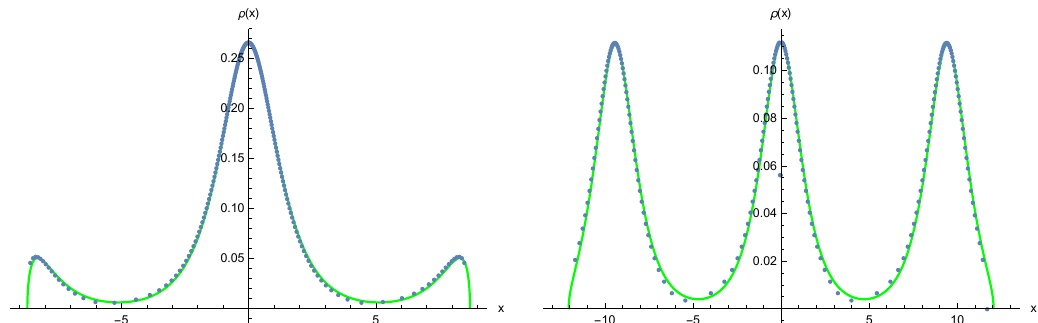
Figure 3 . These (cid:12)gure shows the density function (cid:26) ( x ) (3.54) (green line) and the numer- ical one from the saddle point equation (blue dots). The left and right (cid:12)gures correspond to ( N , N f , m )=(200,1000,3) and (200,420,3)